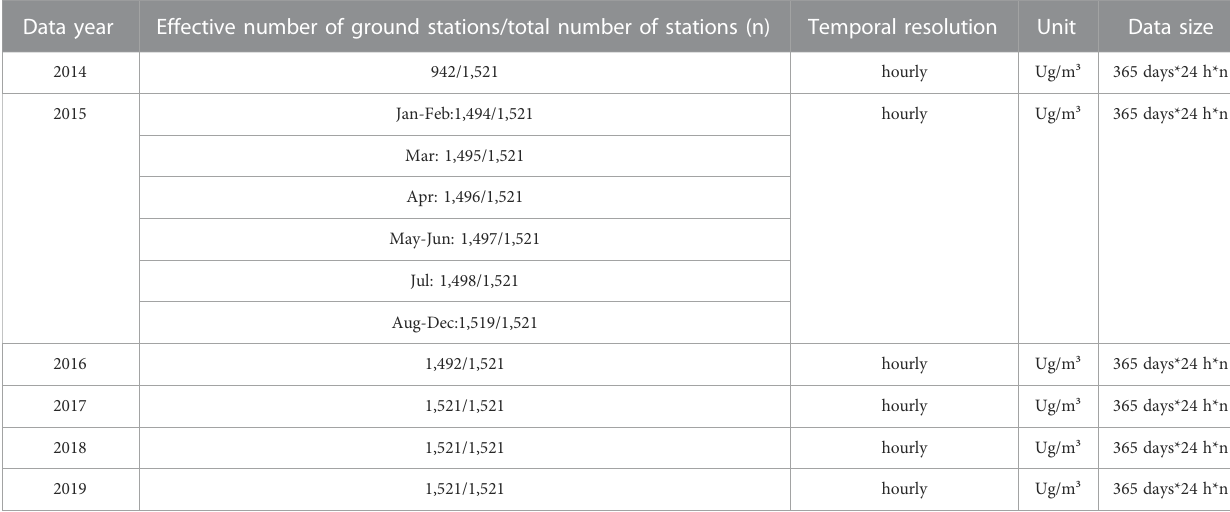
TABLE 1 O 3 concentration data of ground observation stations.